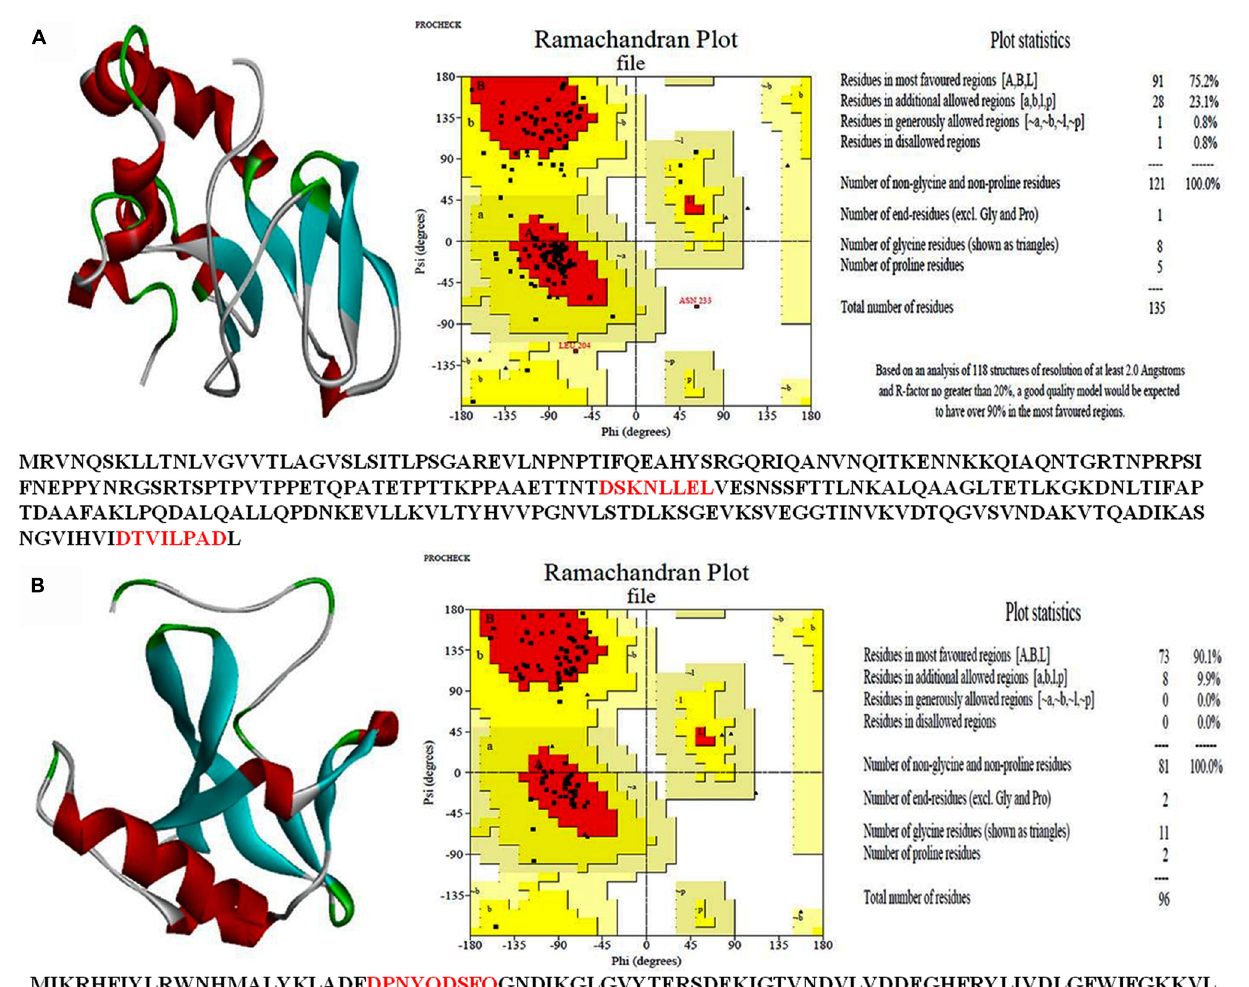
FIGURE 7 | 3-D structure of hypothetical proteins. (A) -all3797 (PDB ID PM0077736), and (B) all4050 (PDB ID PM0077737) obtained from CPHModels (http://www.cbs.dtu.dk/services/CPHmodels/) and PDBSum (http://www.ebi.ac.uk/pdbsum/).